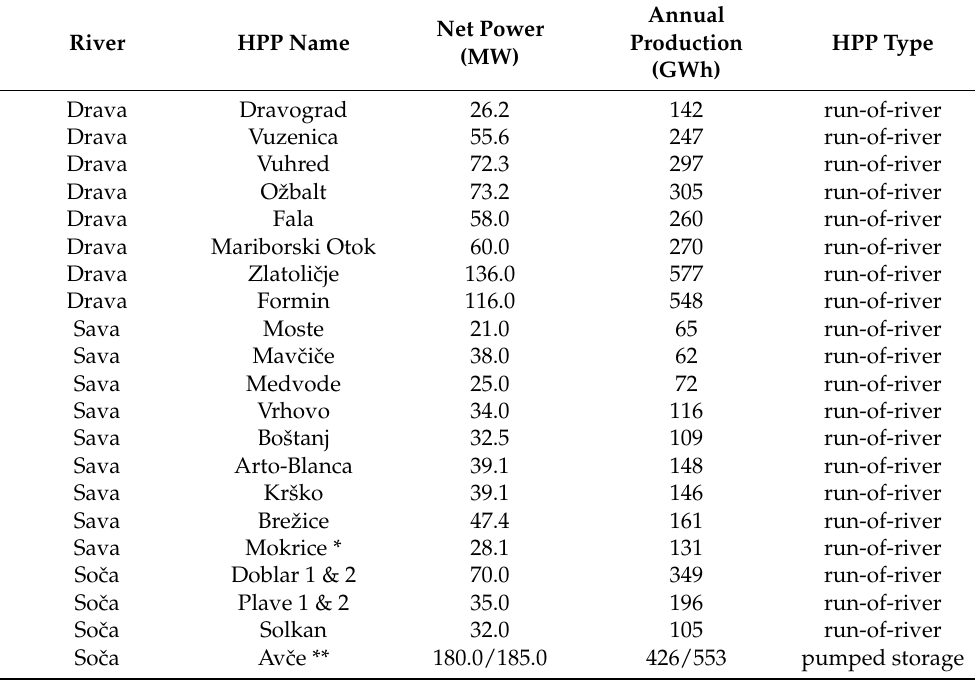
Table 2. Basic data on large existing hydropower plants in Slovenia.